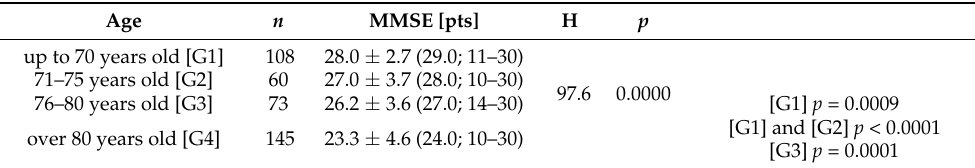
Table 1. Descriptive characteristics for MMSE depending on the age group and test results for the Kruskal–Wallis test.